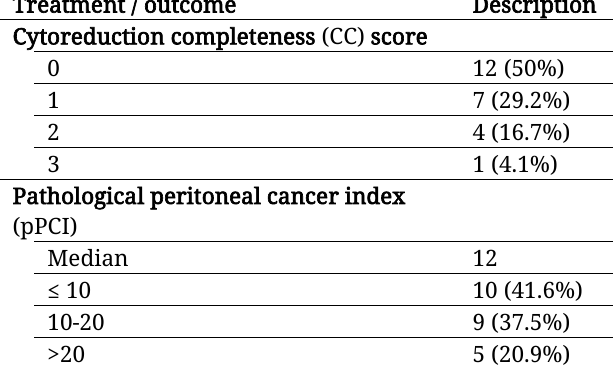
Table 3: Summary of surgery outcome, HIPEC, IORT, and postoperative treatment Treatment /